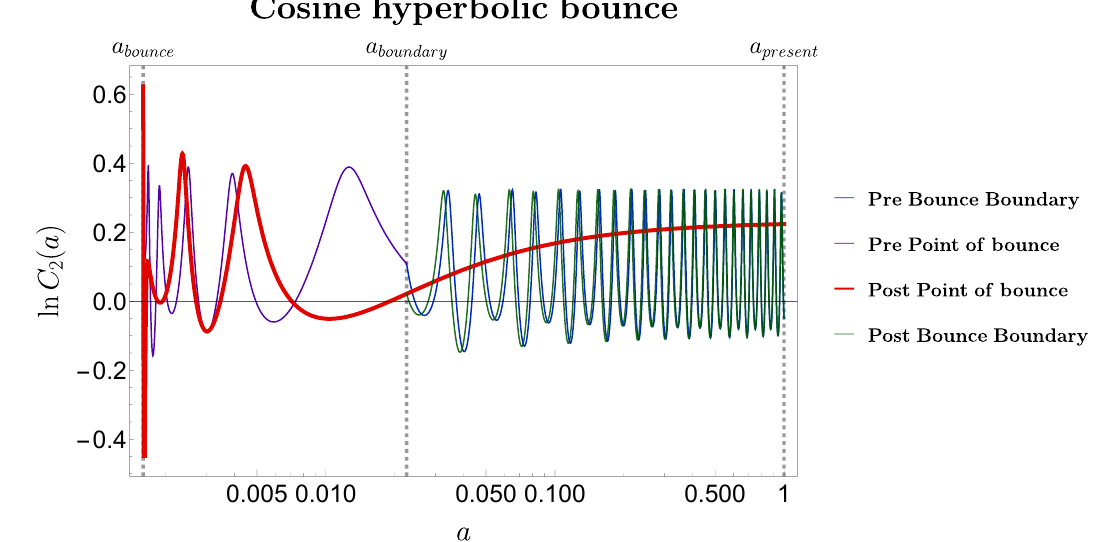
Figure 15: Logarithm of Geodesically weighted Complexity value at different regions plotted against scale